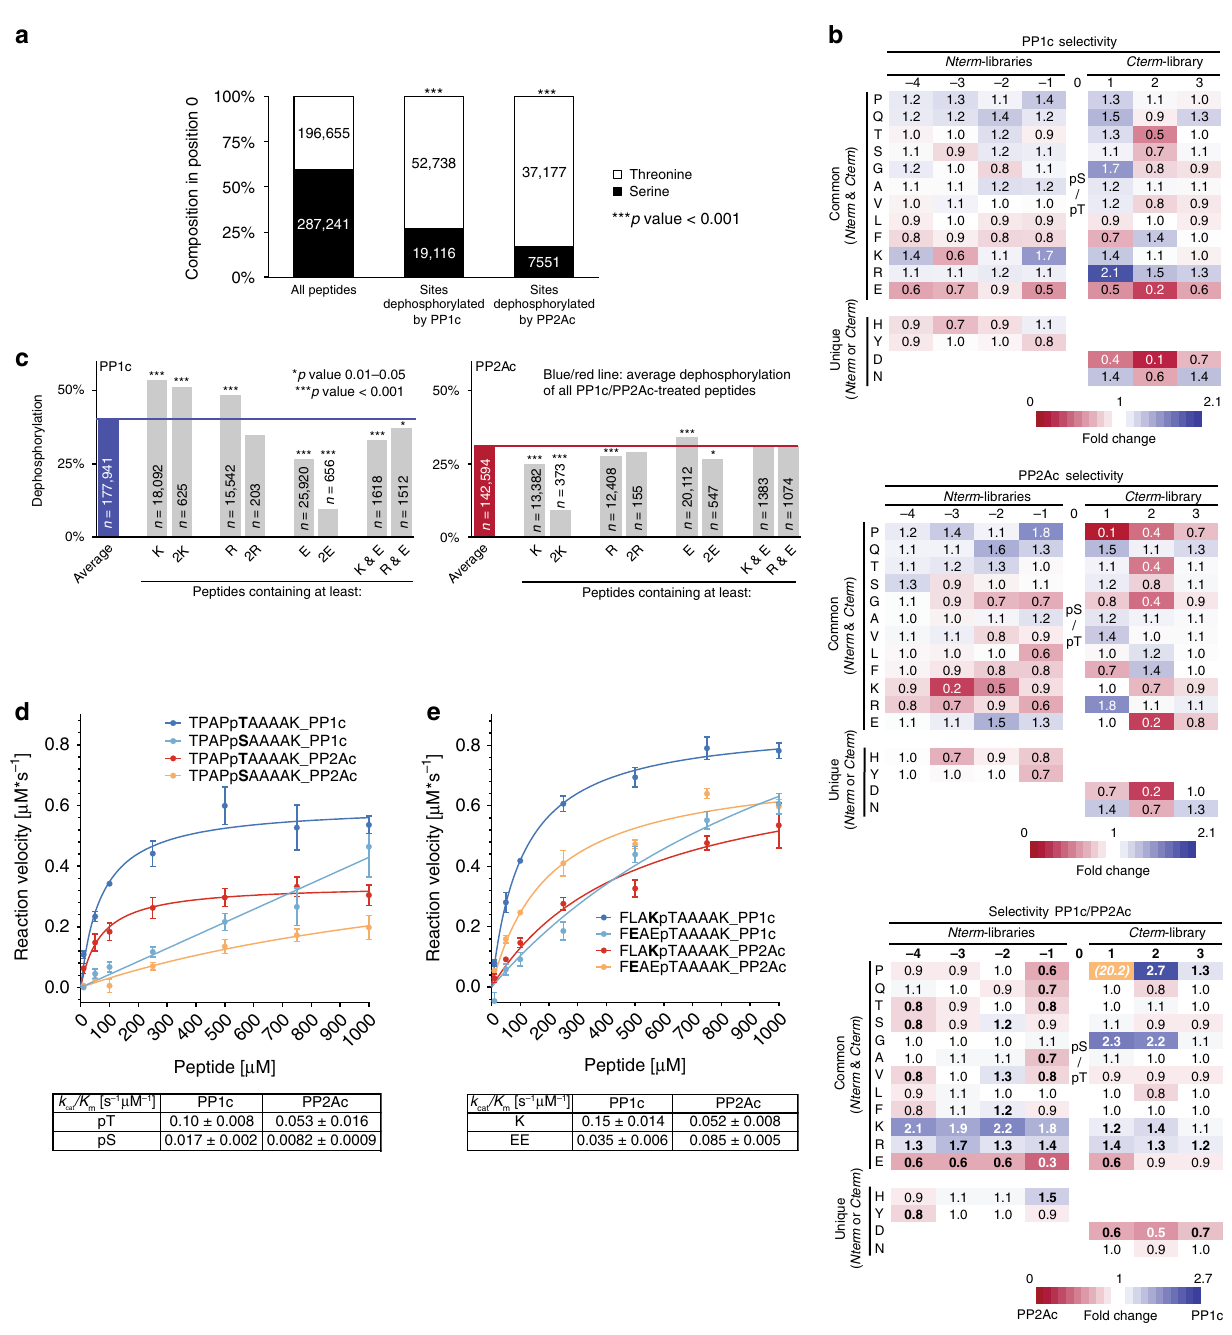
Fig. 2 Analysis of PP1c/PP2Ac amino acid preference using the PLDMS approach. a PP1c and PP2Ac preferably dephosphorylate pThr over pSer. For statistical analysis, a two-sided Fisher ’ s exact test was used. b Heat-map analysis of the sequence context surrounding pSer/pThr dephosphorylated by PP1c and PP2Ac. Color coding: Phosphorylation-fold-change of all amino acids compared to the average library dephosphorylation. At 1 the dephosphorylation rate of an amino acid is equal to the average dephosphorylation rate. For a third heat map comparing PP1c and PP2Ac, dephosphorylated peptides for each amino acid were divided and Nterm/Cterm heat-maps were normalized by the median. To allow better visualization by color coding, Pro in + 1 was excluded. Fold-changes >1.2 with an adjusted p -value <0.01 according to Fisher ’ s exact test in the comparison of PP1c/PP2Ac are highlighted in bold. Please see the methods section and Source Data for details on statistics. c Analysis of the additive in fl uence of positive and negative charges on dephosphorylation by PP1c/PP2Ac of Nterm/Cterm libraries. p -Values were derived by carrying out a two-sided Fisher ’ s exact test. Exact p -values are provided in the Source Data. d , e Kinetic analysis of the dephosphorylation rate of four synthetic peptides upon PP2Ac or PP1c treatment. Error bars represent s.e.m. of three independent repeats with technical duplicates. k cat / K m was calculated by comparison to a phosphate standard curve. Source data underlying Fig. 2a – e are provided as a Source Data fi